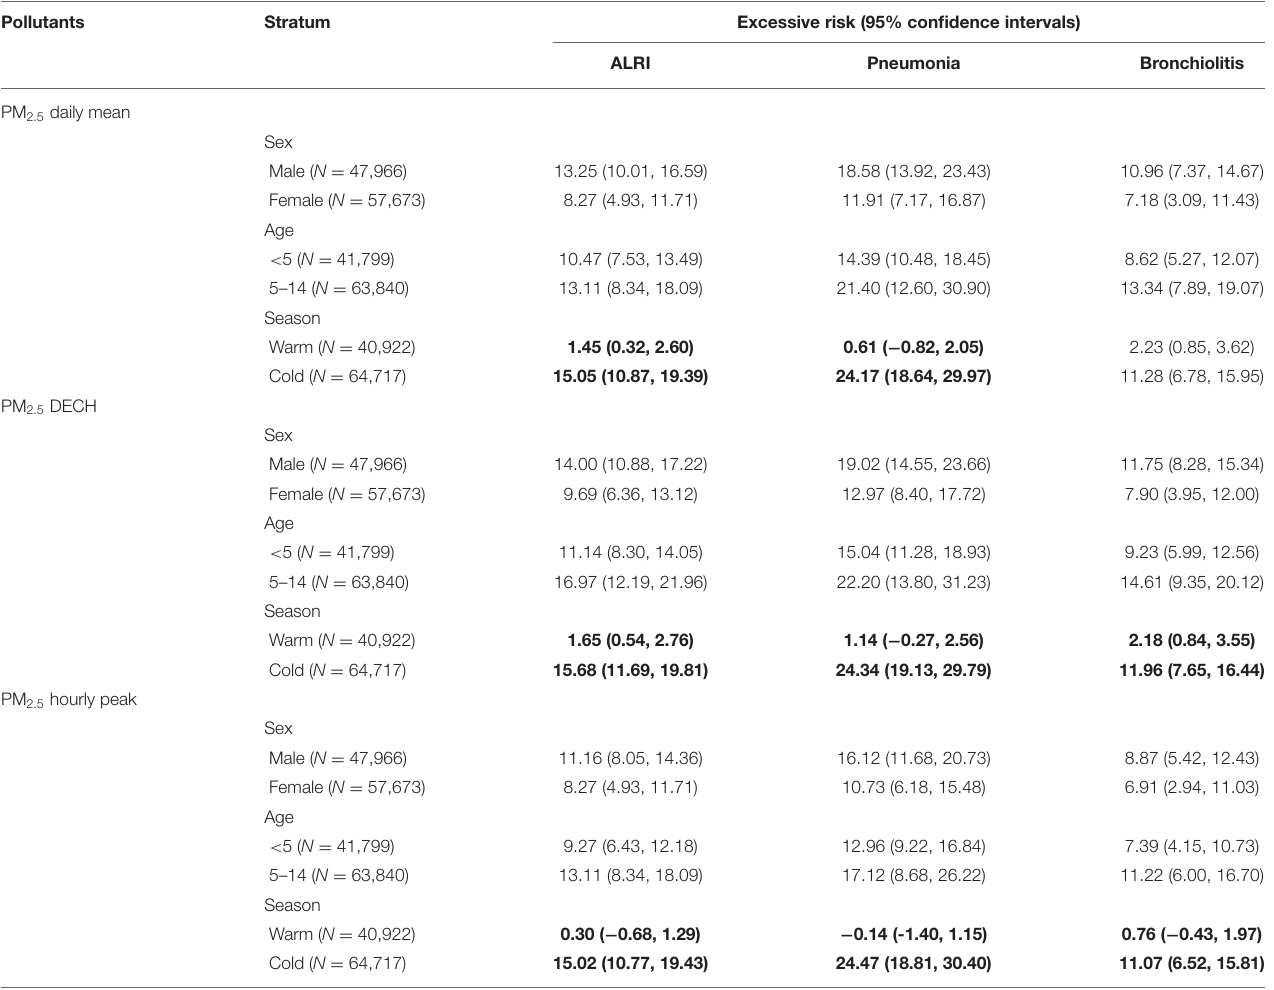
TABLE 3 | Excess risk and 95% confidence intervals of acute lower respiratory infection, pneumonia, and bronchiolitis for per interquartile range increment in ambient PM 2.5 (daily mean, daily excessive concentration hours [DECH], and hourly peak) stratified by gender, age group, and season. Pollutants